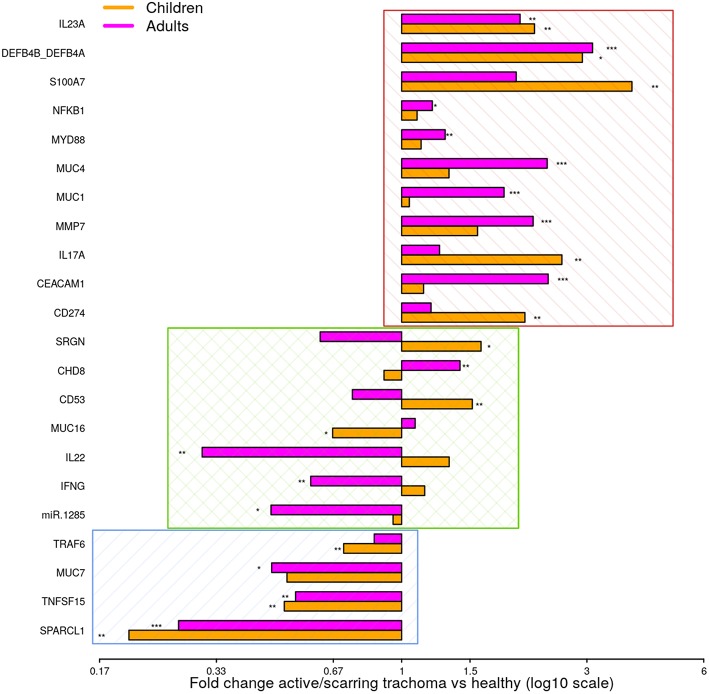
Comparison of fold-changes in conjunctival gene expression between active/scarring trachoma cases and healthy controls. Fold-changes in gene expression between children with active trachoma and healthy controls (orange bars) and adults with scarring trachoma and healthy controls (purple bars) are represented by bars with significance indicated as described below. Genes are sorted into three groups; downregulated in active and scarring trachoma (blue area), upregulated in active and scarring and trachoma (red area), and differentially regulated in active and scarring trachoma (green area). P-values were considered significant at <0.05 and are denominated as follows: *p < 0.05; **p < 0.01; and ***p < 0.001.